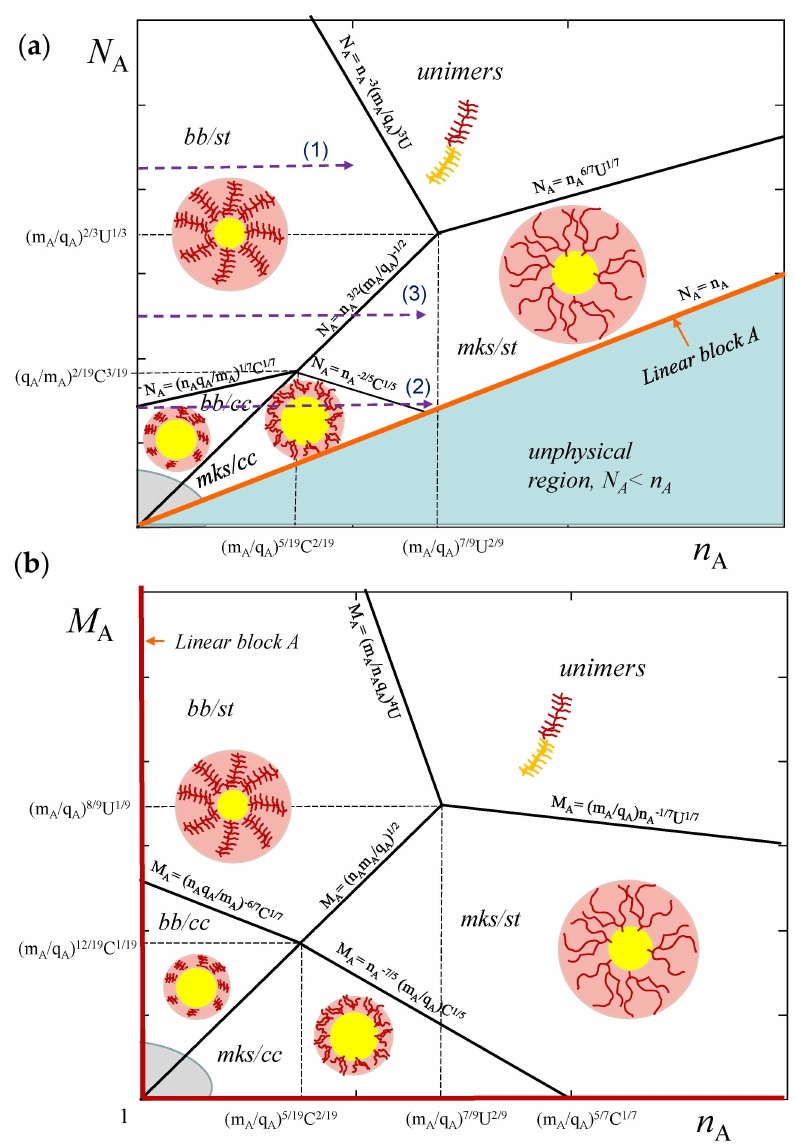
Figure 3. Schematic diagram of states of micelles in ( N A , n A ) ( a ) and ( M A , n A ) ( b ) coordinates. Regions of starlike (st) and crew-cut (cc) micelles with bottlebrush (bb) or miktostar (mks) A-blocks are outlined. Equations for boundaries between different regimes are presented near the lines. Parameters of the boundaries in the diagram are C ∼ = ( γ 2 ( N B / φ B ) 5 v − 3 ) 1/7 ; U = γ 5 ( N B / φ B ) 10/3 v − 2 . Gray area corresponds to the region of spherical micelles instability (transition to wormlike micelles and